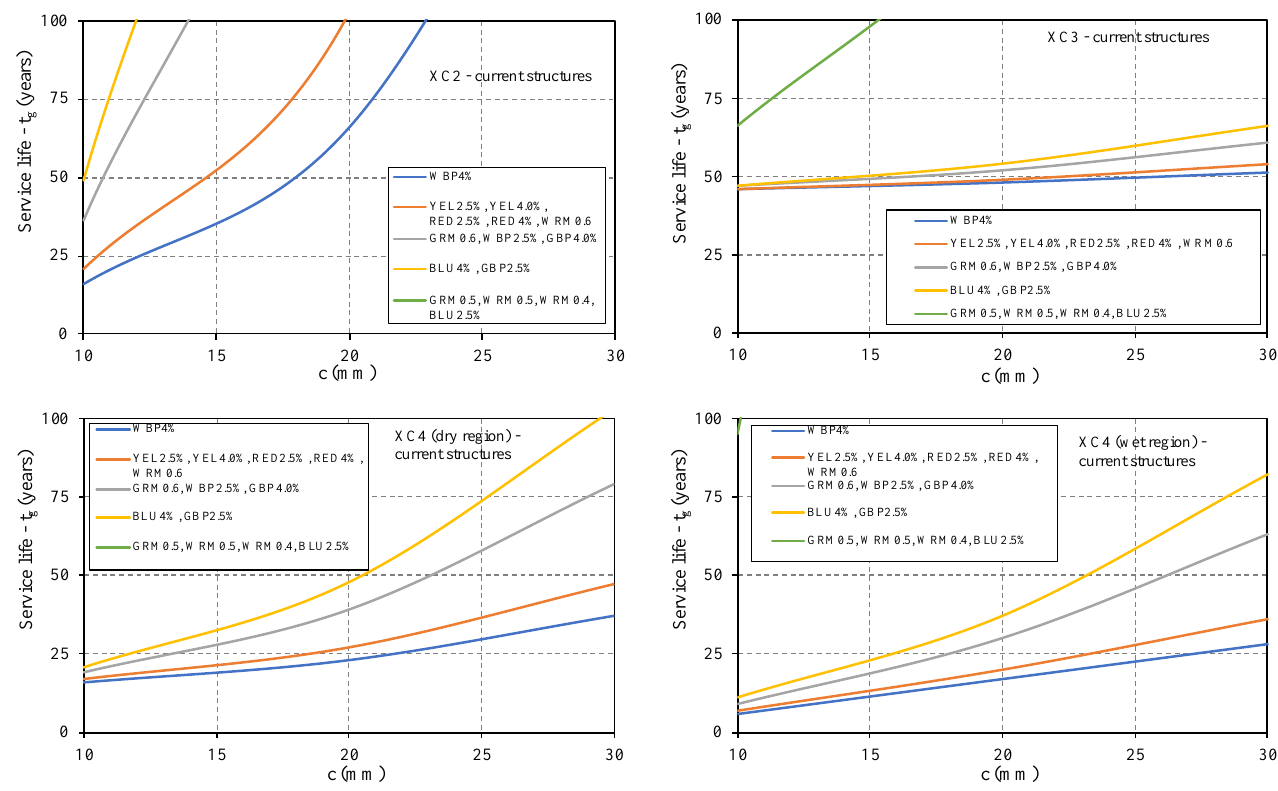
The service life was computed for different exposure classes (for current structures), for a cover equal to 10, 20, and 30 mm (see Figure 10). The results are only conditioned by the requirements to protect the steel reinforcement against corrosion, not taking into account the fire resistance and the proper transmission of bond stresses between the rebars and the surrounding mortar.